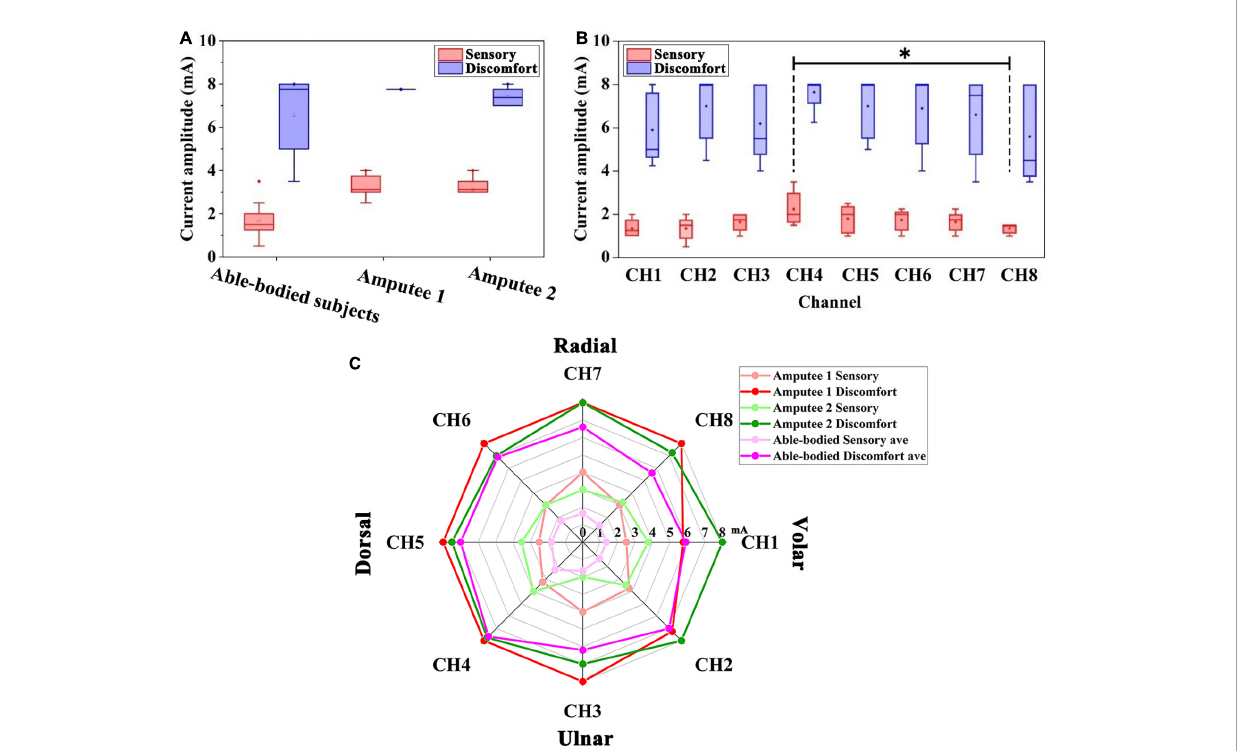
FIGURE5 (A) Distribution of the sensory threshold and discomfort threshold of able-bodied subjects and two amputees. (B) Sensory threshold and discomfort threshold of able-bodied subjects among the eight positions. Black stars show the comparison of the sensory threshold for the eight positions. ∗ p < 0.05. (C) Radar chart of the sensory threshold (light red, light green, and light purple) and discomfort threshold (red, green, and purple) around the forearm of five able-bodied subjects, amputee 1 and amputee 2. The dots in radar chart correspond to the threshold for eight electrodes around the forearm of the subjects.